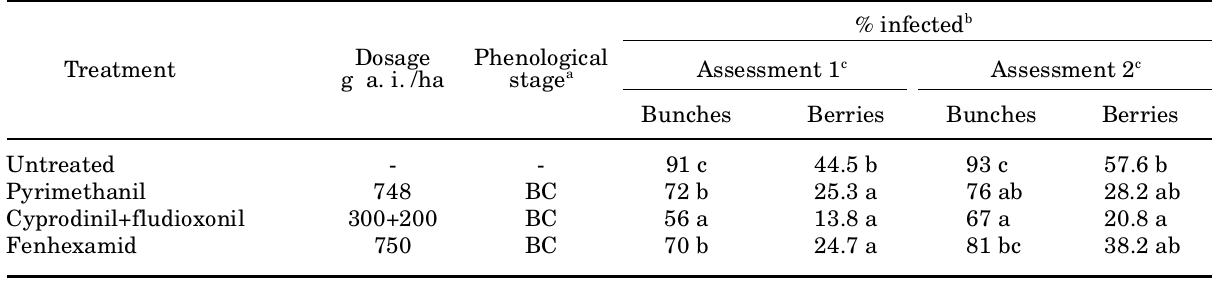
Table 10. Trial 3. Efficacy of different fungicides against Botrytis cinerea on grapevine, cv. Moscato, Aimasso farm, Valdivilla, 1999.